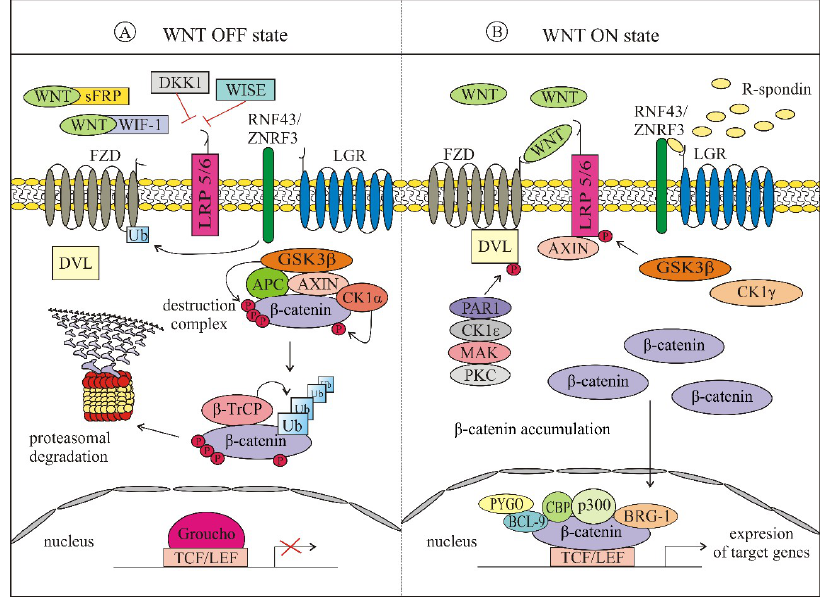
Figure 1. Simplified scheme of canonical WNT -signaling pathway. ( A ) In the absence of WNT ligands (WNT OFF state), β-catenin is phosphorylated by a destruction complex consisting of AXIN, APC, GSK3β and CK1α to be further ubiquitinated for proteasomal degradation. In the absence of R-spondins, E3 ubiquitin ligases RNF43 / ZNRF3 target FZD for lysosomal degradation; ( B ) binding of WNT ligands to FZD receptors and LRP co-receptors activates WNT-signaling